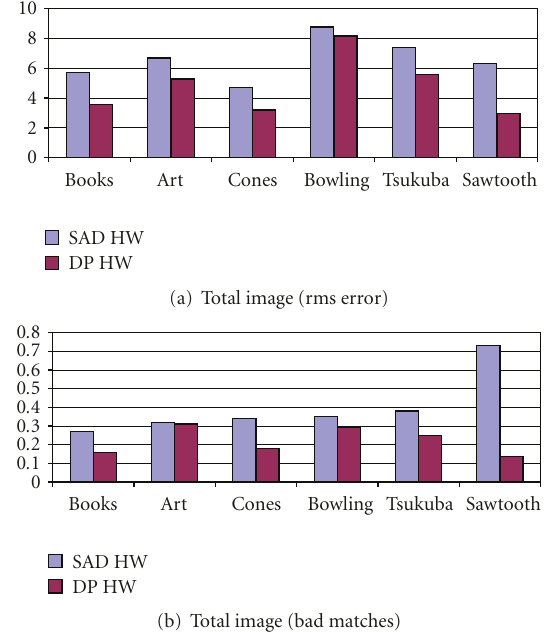
Figure 14: Error statistics computed over the whole image. (a) rms error, (b) percentage of bad matching pixels.